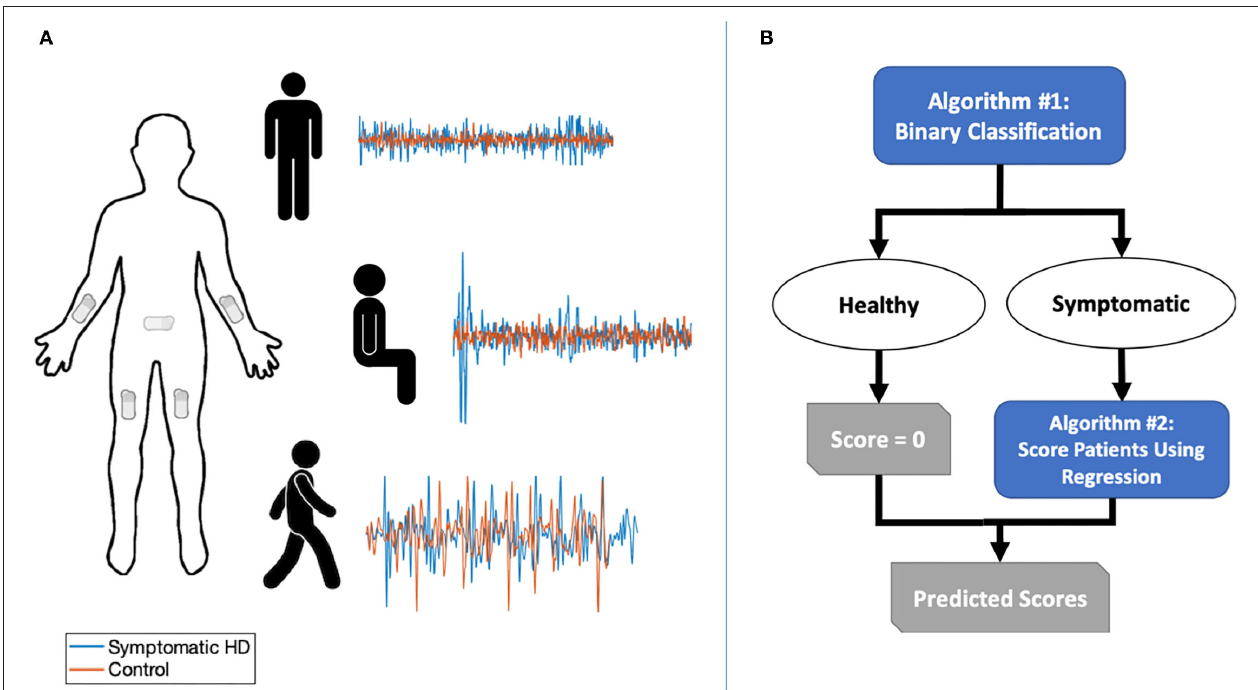
FIGURE 1 | (A) Sensor placement and sample of combined triaxial acceleration data for symptomatic HD participants and controls in three tasks: standing with feet apart for 30s; sitting for 30s with feet planted and back unsupported; and walking along an 11-yard straight path over five repetitions. (B) Two-stage classification and prediction